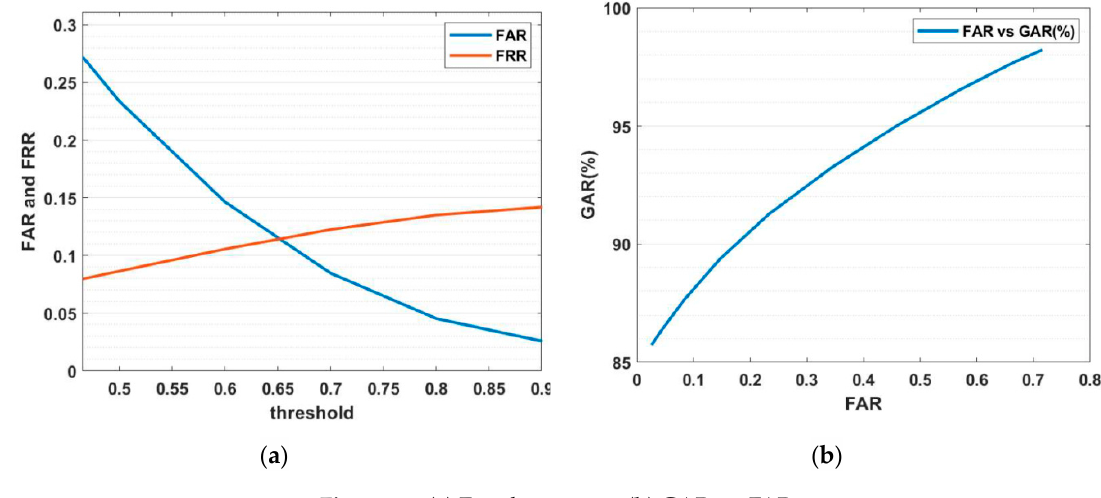
Figure 10. ( a ). Equal error rate; ( b ) GAR vs. FAR. Figure 10. ( a ) Equal error rate; ( b ) GAR vs.